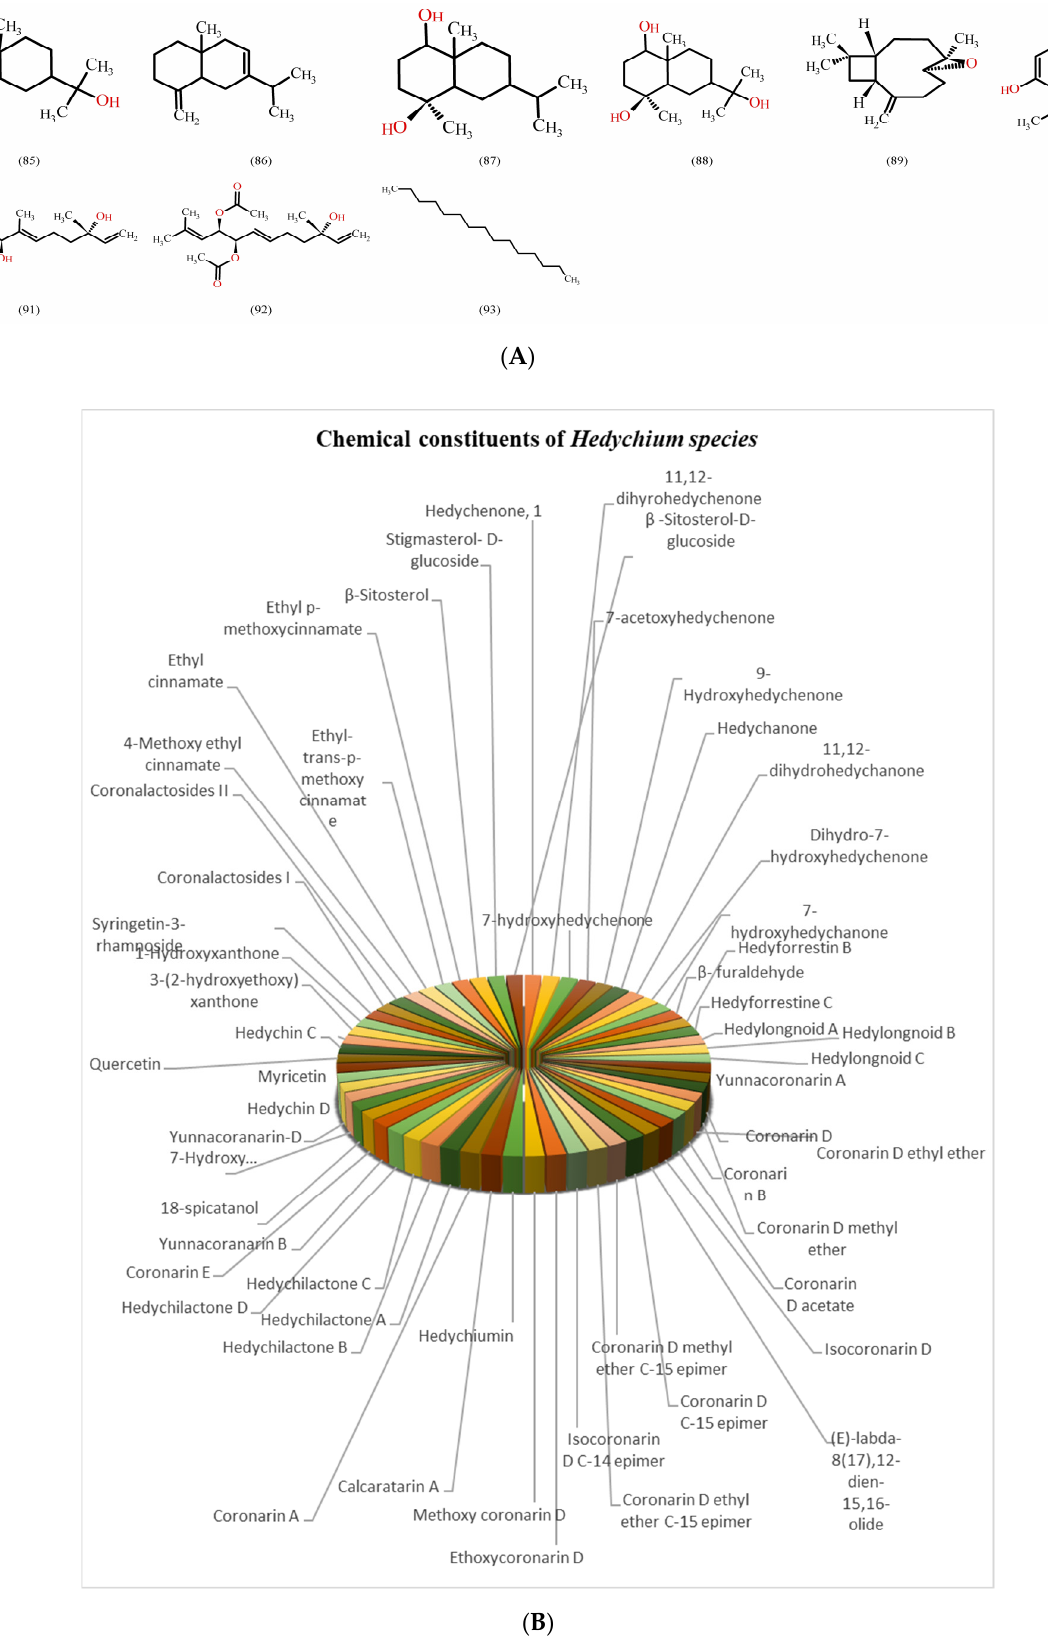
Figure 2. ( A ). Chemical structure of Hedychium species. ( B ). Chemical constituents of Hedychium species .